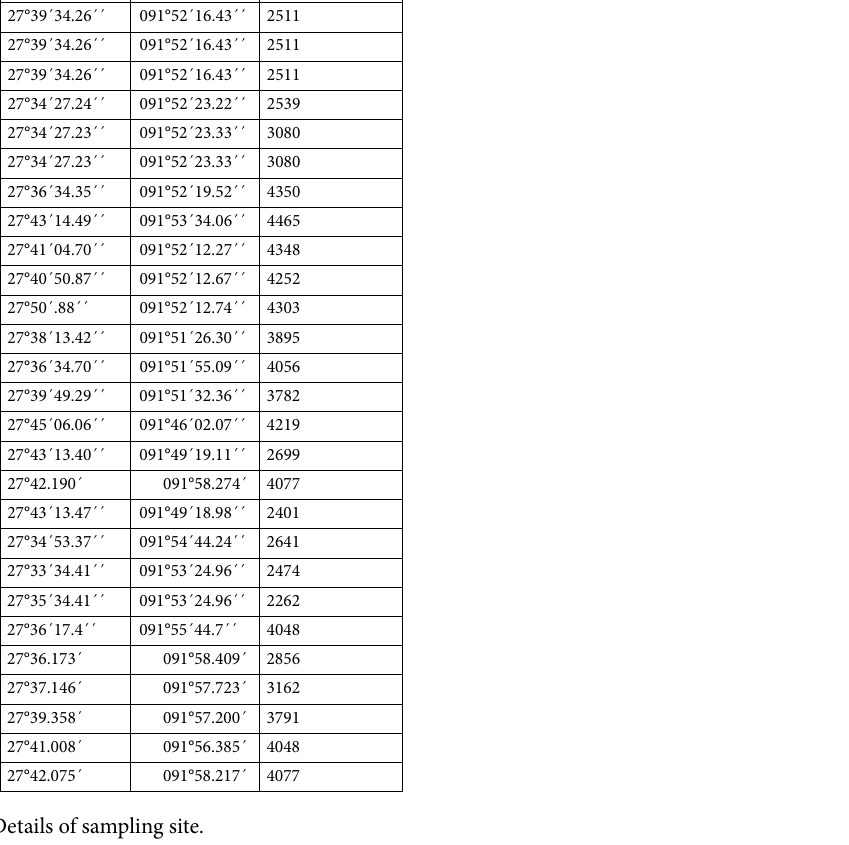
Table 1. Details of sampling